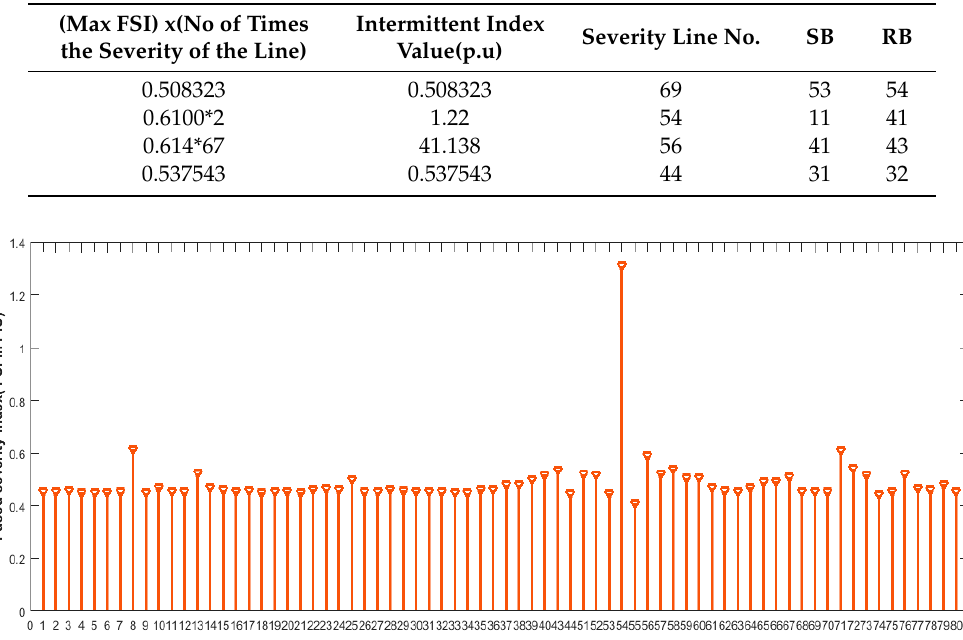
Figure 7. Box plot for fused severity index values for various line outages. Table 8. Different parameters for the IEEE57bus system using the grey wolf algorithm. Quantity